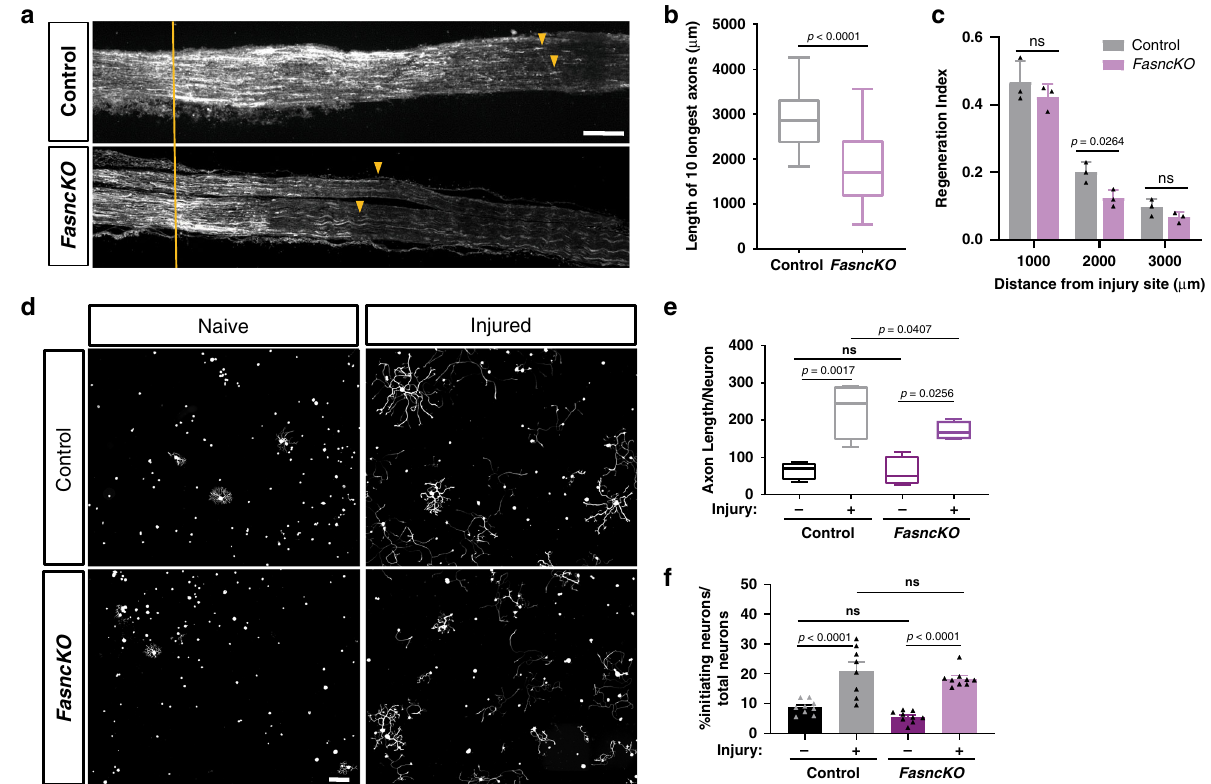
Fig. 6 Fasn deletion in SGC impairs axon regeneration. a Representative longitudinal sections of sciatic nerve from control and FasncKO mice 3 days after sciatic nerve injury, stained for SCG10. Orange lines indicate the crush site, identi fi ed as the maximal SCG10 intensity. Arrowheads indicate longest regenerating axons. Scale bar: 500 µ m. b Length of the longest 10 axons was measured in 10 sections for each nerve. c Regeneration index was measured as SGC10 intensity normalized to the crush site. d Representative images of dissociated DRG neurons from control and FasncKO , cultured for 20h, from naïve and injured (3 days post conditioning sciatic nerve injury) and stained with the neuronal marker TUJ1. Scale bar: 200 µ m. e The length of axons per neuron was measured. Automated neurite tracing analysis using Nikon Elements of about 500 neurons per replicate. f Percentage of initiating neurons normalized to the total number of neurons was measured in 8 independent animals, average of 500 neurons per replicate. Automated neurite tracing analysis using Nikon Elements. One way ANOVA. Sidak ’ s multiple comparisons test ns-non-signi fi cant. n = 8 biologically independent animals examined over 2 independent experiments for ( a – f ). P values determined by two tailed t test presented in ( b ) and One way ANOVA followed by Sidak ’ s multiple comparisons test in ( c , e and f ). Data are presented as mean values ±SEM. The boxplots in b and e extends from the 25th to 75th percentiles and the whiskers go down to the smallest value and up to the largest where the box middle line is the median. Source data are provided as a Source Data fi le for ( b , c , e , f